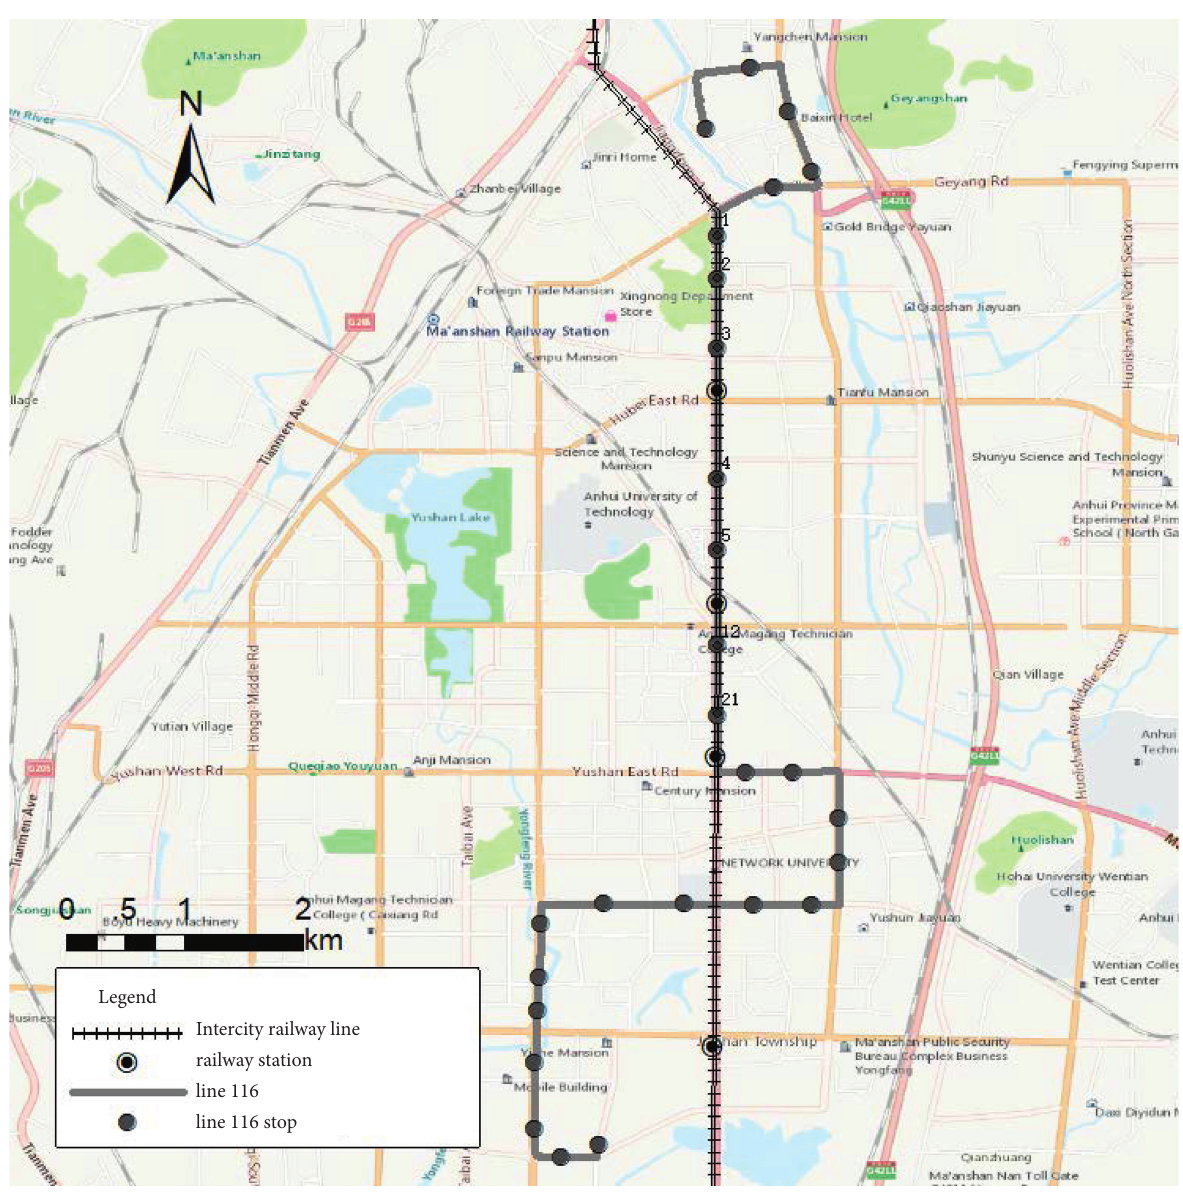
Figure 9: Alternative plans and stops of line 116.